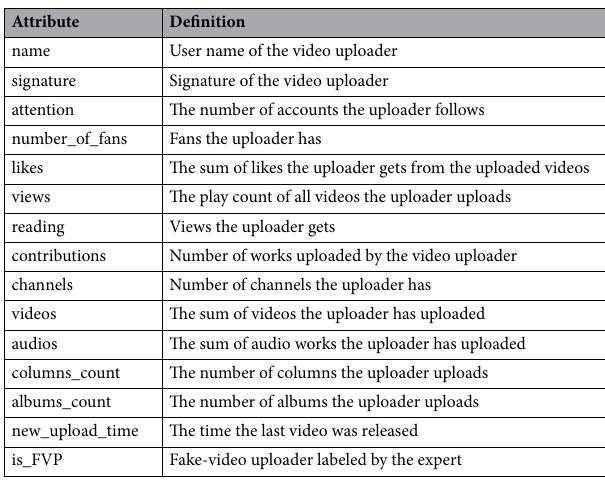
Table 1. Attributes of video uploaders and corresponding